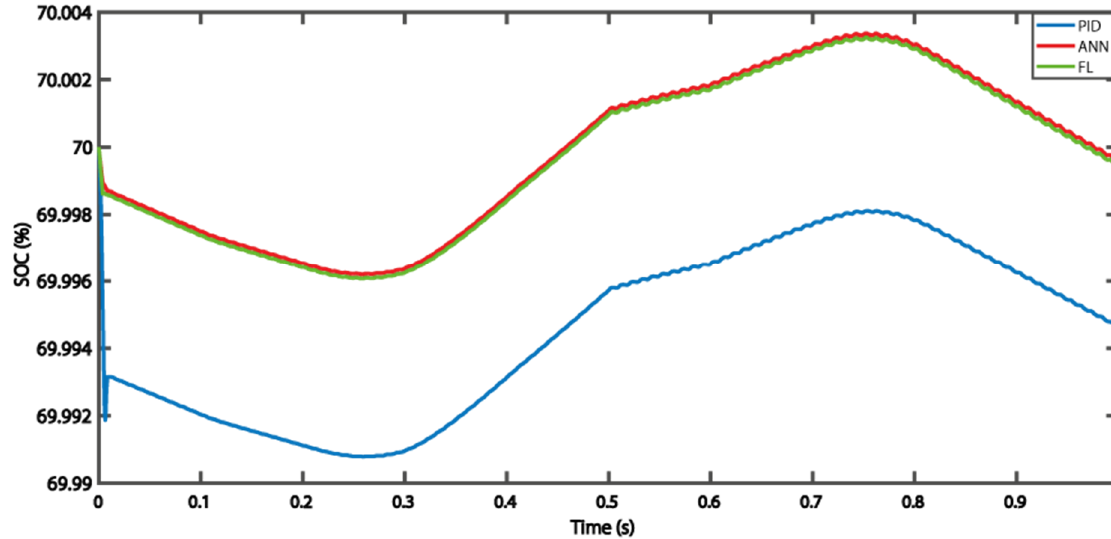
Figure 18. Variation in the battery state of charge (%).